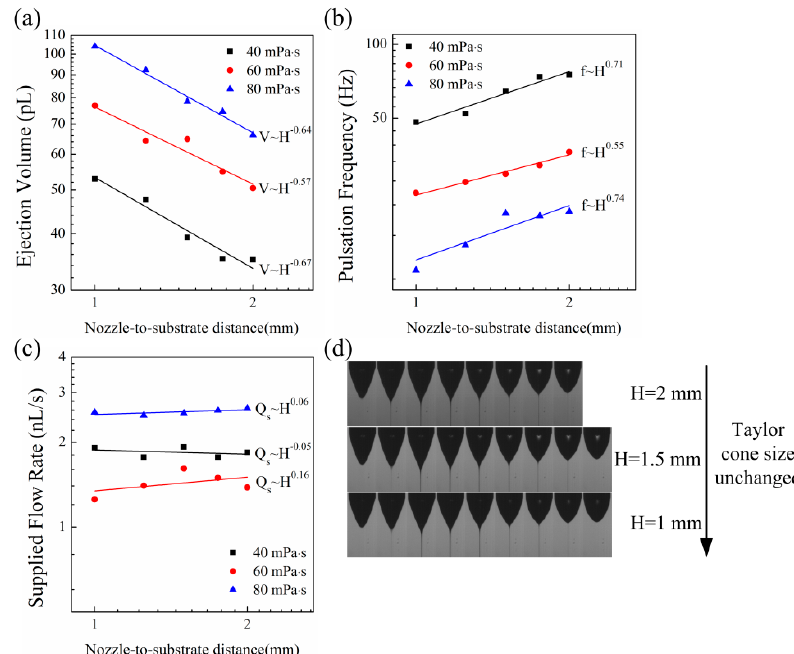
Figure 6. The ejection for different nozzle-to-substrate distances: ( a ) the relation of the ejection volume and nozzle-to-substrate distance; ( b ) the relation of the pulsation frequency and nozzle-to-substrate distance; ( c ) the relation of the supplied flow rate and nozzle-to-substrate distance; ( d ) the image of the ejection process for different nozzle-to-substrate distances. The conductivity of the liquid was 6 µ S/cm. The dimensionless applied voltage was U (cid:48) = 9.424.